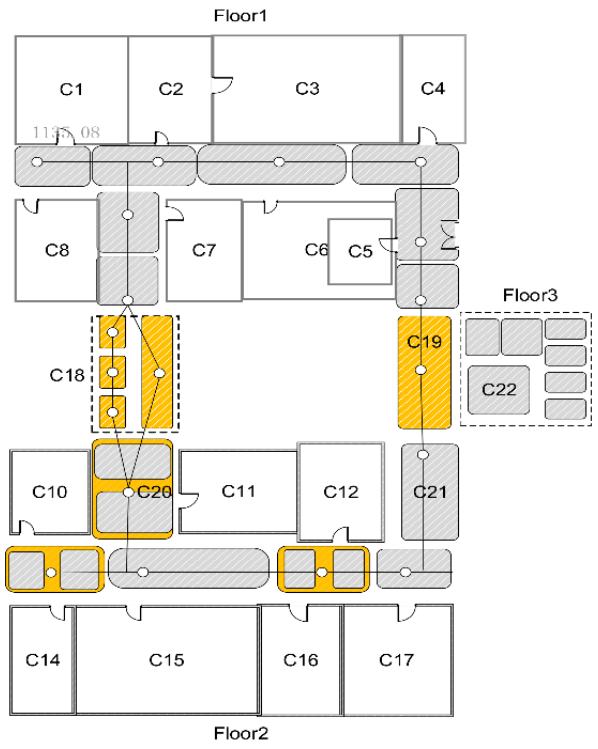
Figure 10. Multi-floor indoor cellular space.C18 is the stairwell, and C19 is the elevator.